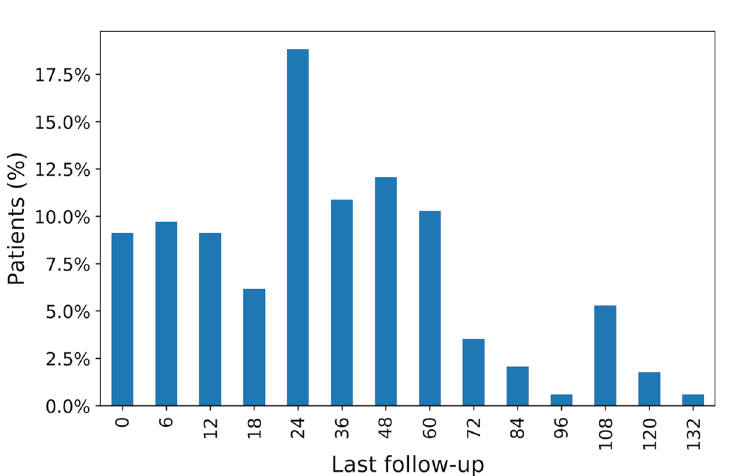
Figure 2. The percentage of patients with last follow-up. Different motivations can cause the interruption of follow-up, such as the onset of the disease, familial and logistic problems, mobility, unavailable blood